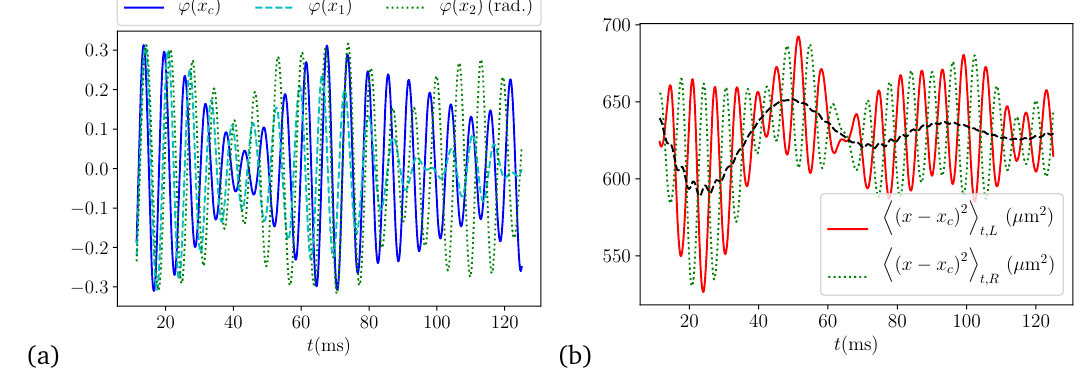
Figure 13: Additional plots for the same parameters as Fig. 11(a). (a) relative phase at the trap center ( x = x squared longitudinal size (68) of left and right gases ( red and green ) as well as their average ( black